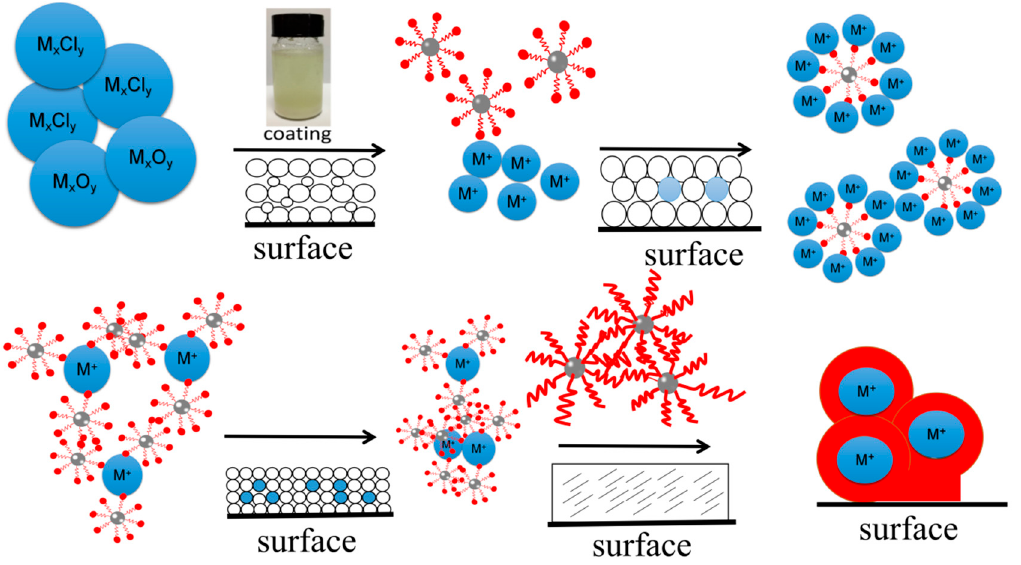
Figure 7. The activity of decontaminant on insoluble nuclide compounds.